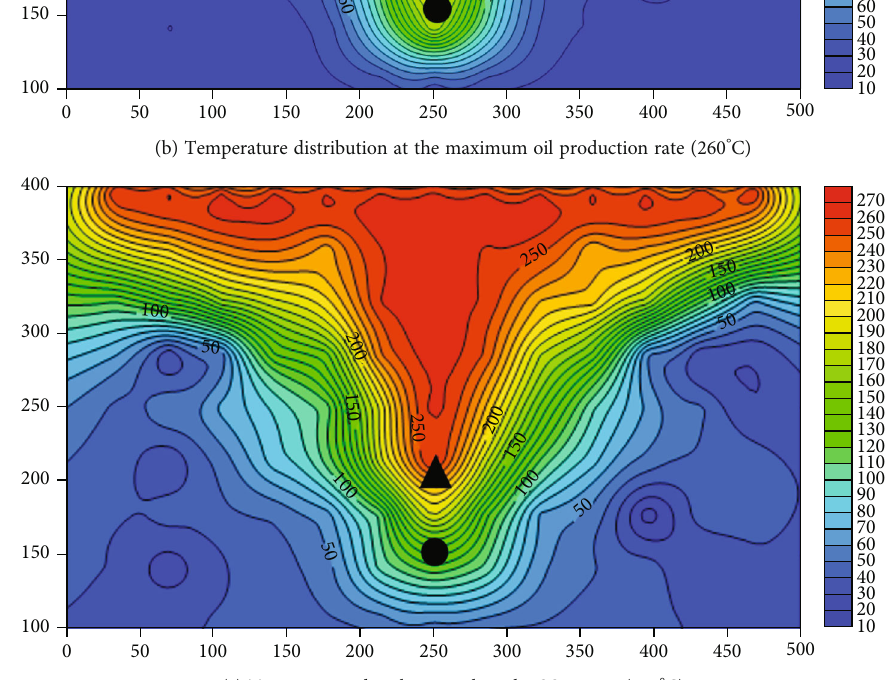
Figure 9: Temperature distribution in di ff erent periods (260 °